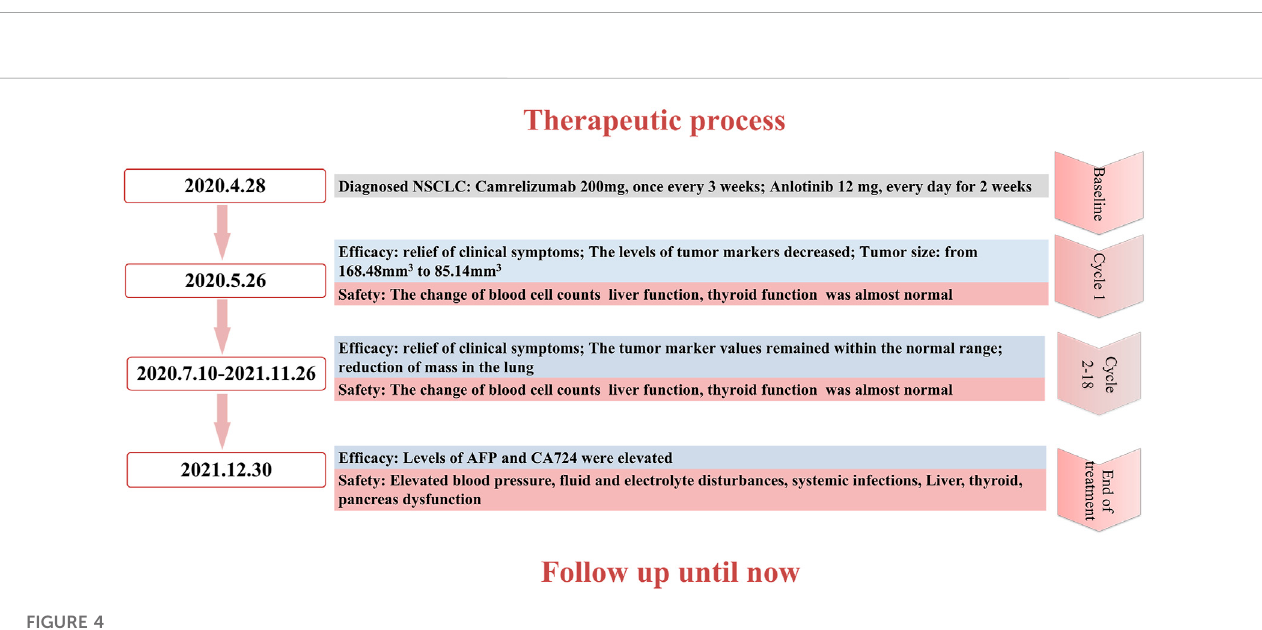
(Figure 2C). Blood cell counts (Supplementary Table S2; Figure 3A), liver function (Supplementary Table S3; Figure 3B), thyroid function (Supplementary Table S4; Figure 3C), and pancreatic function (Supplementary Figure S1) were nearly within normal limits.